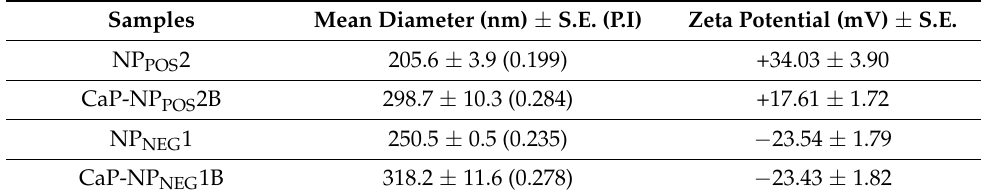
Table 5. Mean diameters and Zeta potential values of NP POS 2 and of NP NEG 1, uncoated and coated via method B.